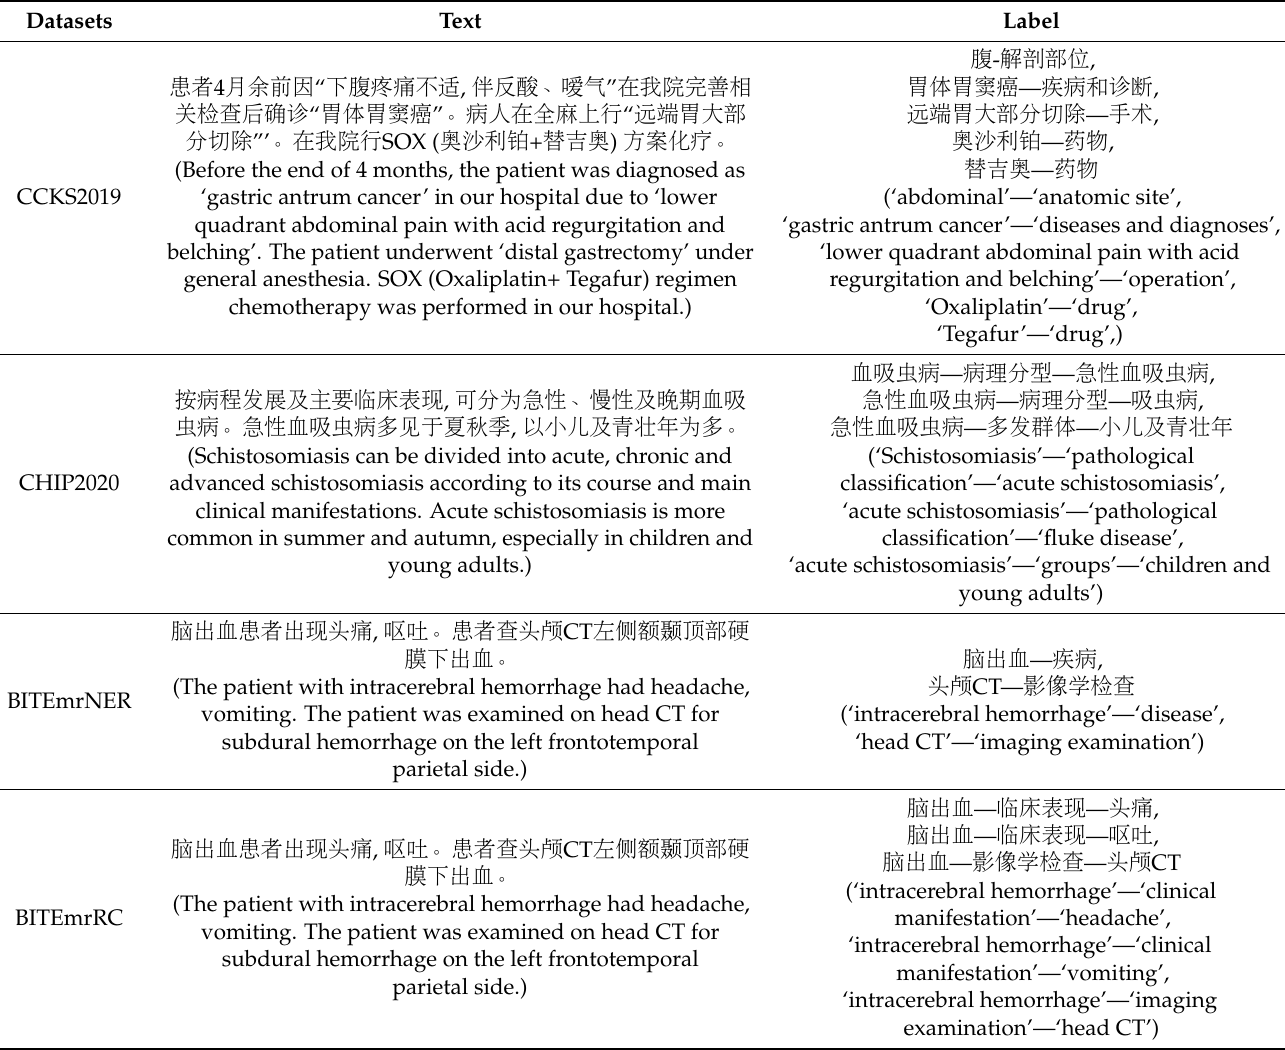
Table 4. The samples of